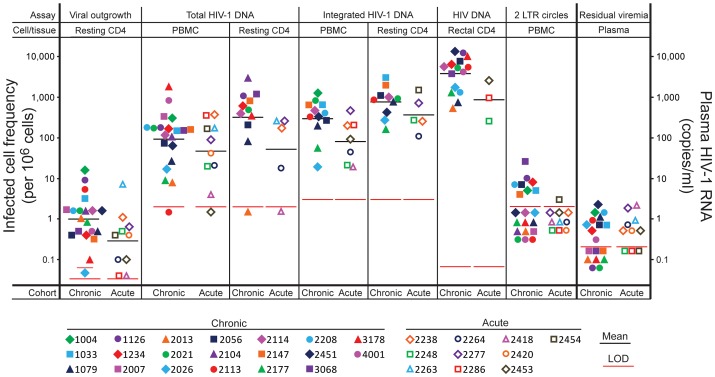
HIV-1 persistence assessed by six different assays performed on the indicated cell or tissue obtained from patients starting HAART during acute/early infection (open symbols) or chronic infection (closed symbols).Geometric mean values are indicated by a horizontal black line. Long red lines indicate the limit of detection (LOD) for the relevant assay with a standard input sample size. Short red lines indicate patient-specific limits of detection in cases where the blood or tissue sample was smaller than normal. Negative assays are indicated by samples plotted below the red LOD lines.